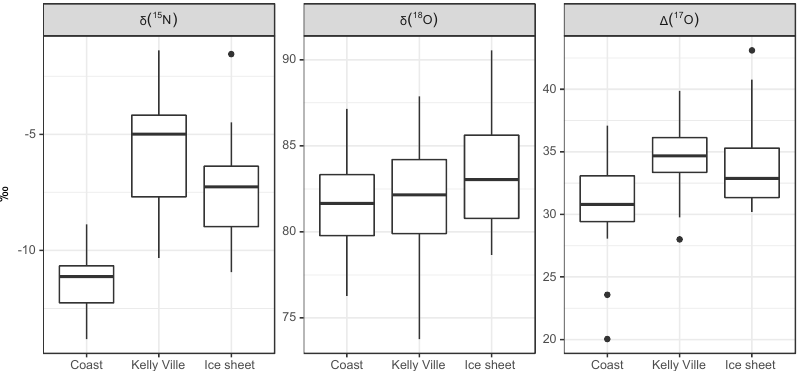
Figure 5. Comparison of regional aggregated ( n = 24 per region) snowpack stable isotope composition of NO − explanation of box